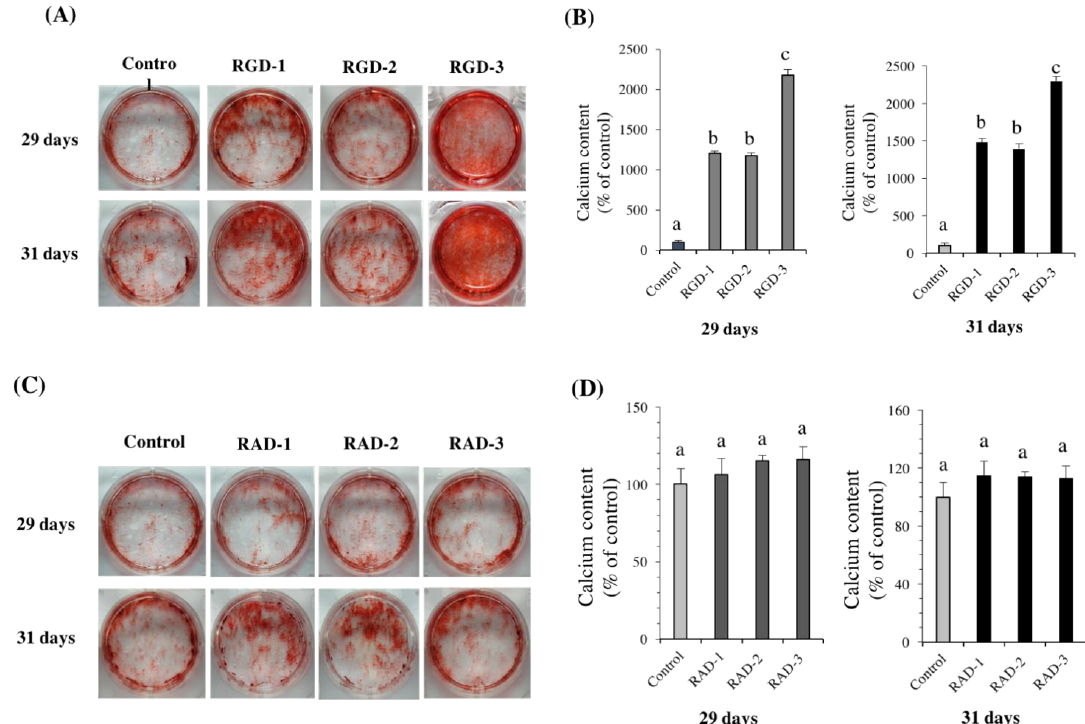
Figure 6. Effects of RGD peptides on hDPSC mineralization. ( A ) Photographs of mineral nodules formed after 29 and 31 days of culture in experiment one. ( B ) CPC quantification of mineralized product staining intensity in ( A ). The RGD-coated groups exhibited a strong promotion of calcific deposition in hDPSCs than the control group on both days 29 and 31. On both days, RGD-3 showed the most prominent staining. CPC quantification in RGD-coated groups was also significantly higher than that in the control group. ( C ) Photographs of mineral nodules formed after 29 and 31 days of culture in the RAD-coated groups. ( D ) CPC quantification of mineralized product staining intensity in ( B ). The RAD-coated groups showed calcific deposition like the control group on both days 29 and 31. CPC data also depict the same results. n = 3, different lowercase characters denote significant differences compared to the control ( p < 0.05 vs. control). 3.6. Effects of MAPK Inhibitors In the ALP activity assay, the p38 inhibitor SB202190 neutralized the effect of RGD-3 to a level comparable to that in the control group on both day 8 and day 22 (Figure 7). The other inhibitors did not have any significant effect on day 8. On day 22, the JNK inhibitor SP600125 had a noticeable inhibitory effect, but much less prominent than the p38 inhibitor. In ARS staining experiment, the p38 inhibitor reduced the matrix mineralization of hDPSCs and showed results comparable to the control, while the other two inhibitors in- duced the same mineralization as that observed in the RGD-3-coated group (Figure 8). CPC quantification data further supported this finding.